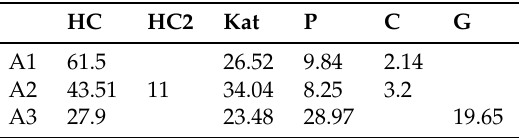
Rietveld refinement of the morphology/crystallinity series of LDHs A1 = SA, A2 = ACE and A3 = M. HC indicates the phase [Ca 4 Al 2 (OH) 12 ][(CO 3 ) · 5H 2 O], HC2 is [Ca 4 Al 2 (OH) 12 ][(CO 3 ) 0.5 Cl 4 · 8H 2 O], Kat is katoite, P is portlandite, C is calcite and G is gibbsite. All values are given in percentages of the crystalline